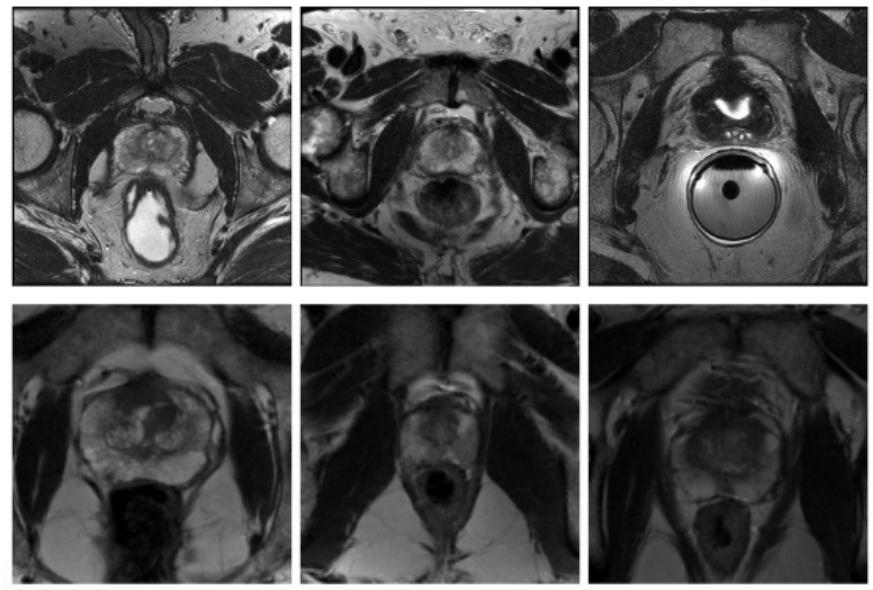
Figure 2. Some slices from different data cohorts to show appearance differences with T2 modality. First row : PROMISE12 dataset. Second row: our clinically collected